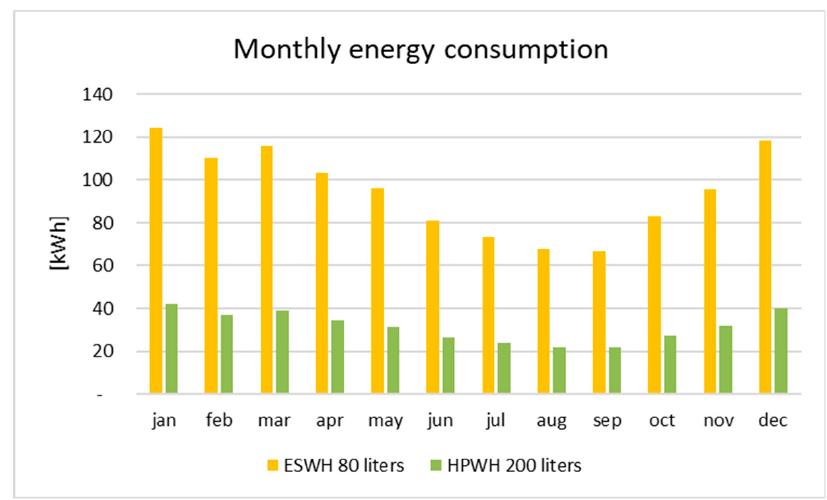
Figure 9. Comparison between electrical storage water heater (ESWH) and HPWH energy consumption.